Question: Give a one-sentence summary of this figure.
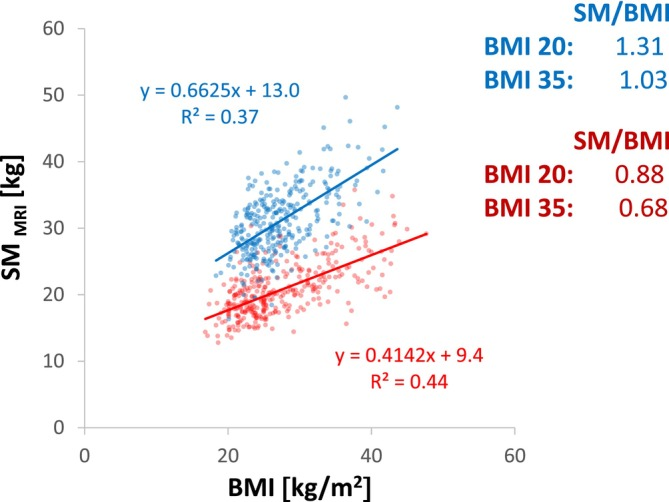
Answer: Different methods for assessing changes in body composition during weight loss.